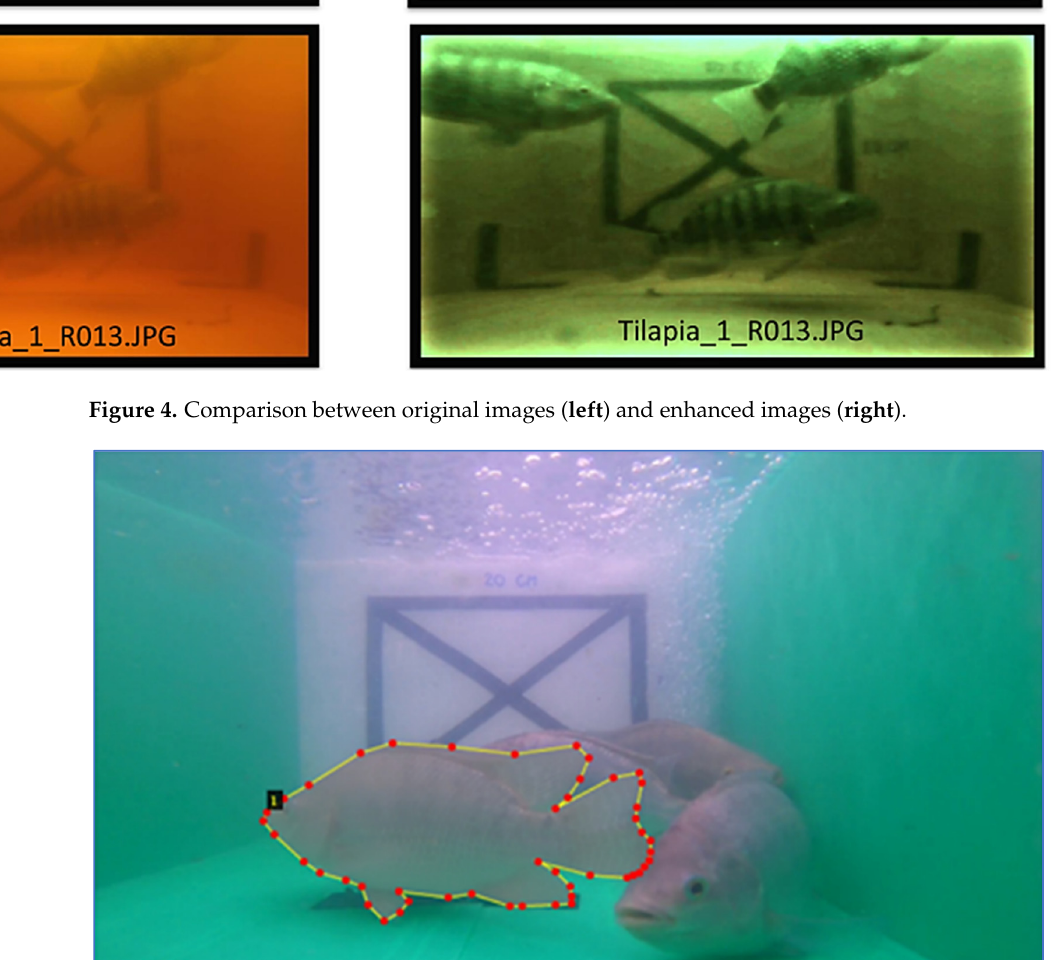
Figure 5. A coordinate-position set of a fish via the image annotation process.